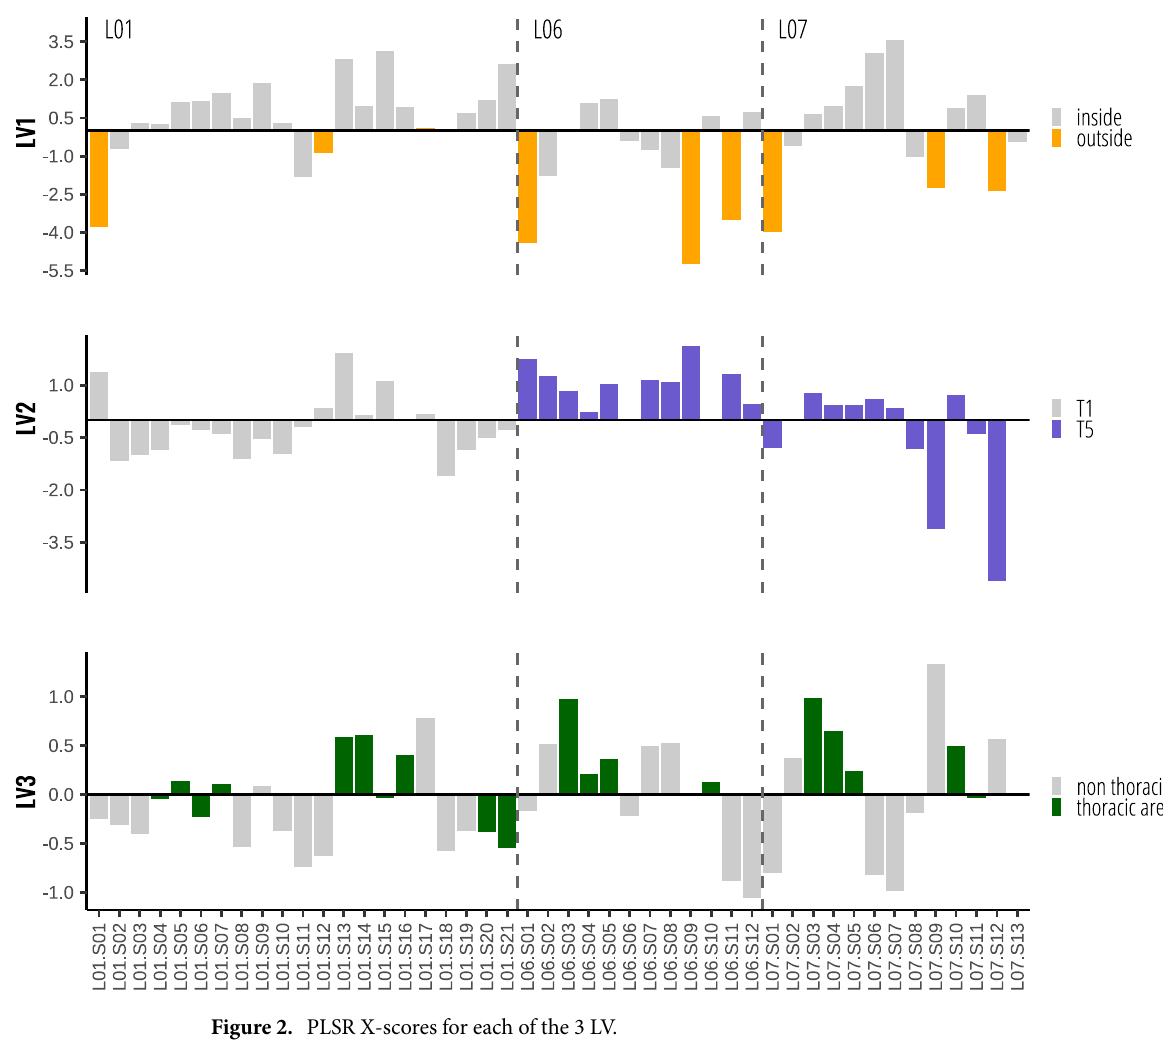
Figure 2. PLSR X-scores for each of the 3 LV.